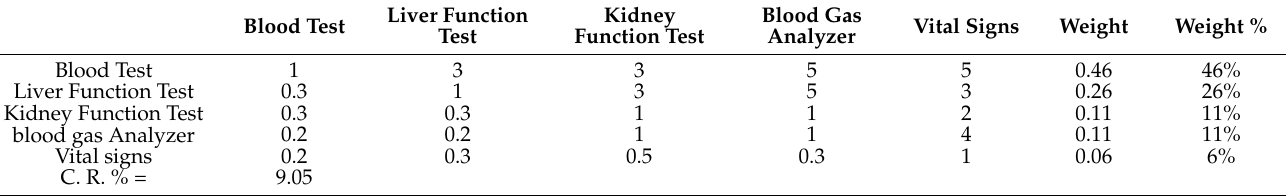
Figure 5. Hierarchy of AHP for clinical variables criteria. Table 4. Decision matrix and weight calculation for Level 2 criteria.